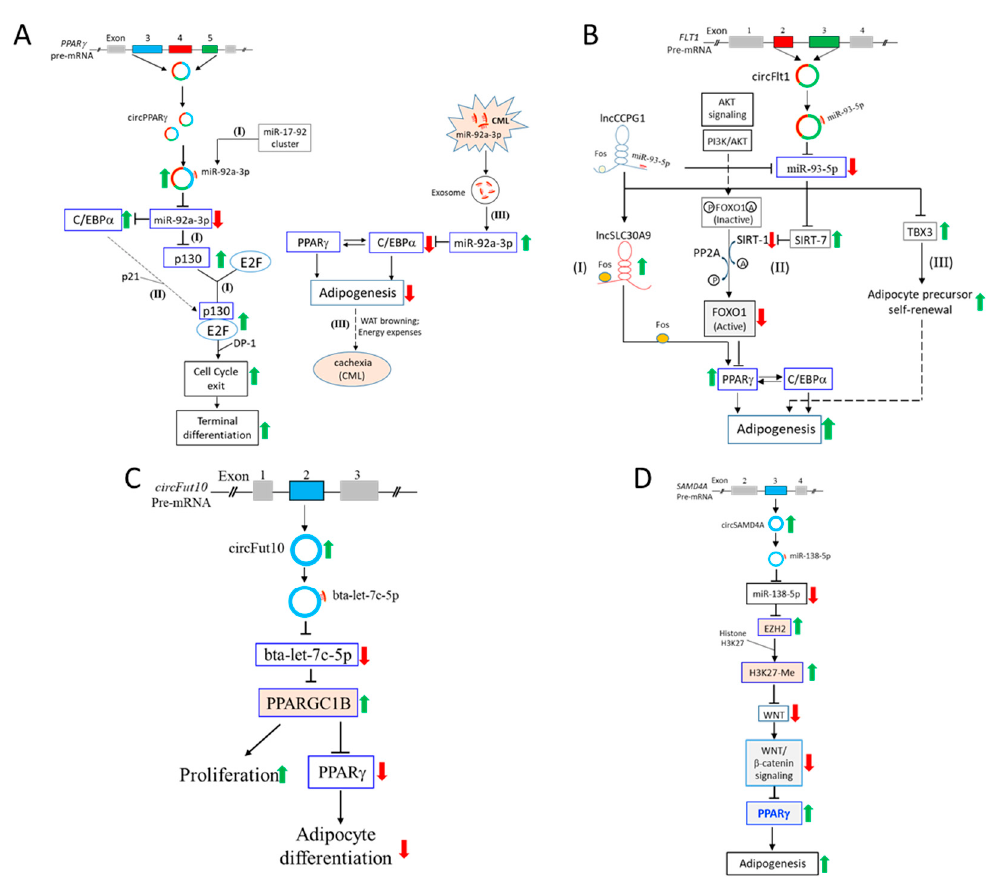
Figure 3. Selected circRNA- and miRNA-mediated post-transcriptional regulation of signaling and biochemical pathways in preadipocyte differentiation. ( A ) CircPPAR γ sponges miR-92a-3p to regulate C/EBP α and p130/Rb2. Depicted are the impacts of circPPAR γ sponging of miR-92a-3p on adipogenesis via p130 (left panel, route I) and C/EBP α (left panel, routes I and II). Cancer-associated cachexia in chronic myeloid leukemia (CML) through adipogenesis is also shown (right panel, route III). ( B ) CircFLT1 sponges miR-93-5p to regulate SIRT-7 and TBX3. Route (I) involves lncCCPG1 and lncSLC30A9 and the c-Fos protein; route (II) depicts SIRT-1 and -7 and the FOXO1 pathway targeting PPAR γ ; route (III) illustrates TBX3 regulation of precursor renewal prior to differentiation in the early stage of adipogenesis. ( C ) The circFUT10-let-7c-5p-PCG1 β regulatory pathway. Negative modulation of preadipocyte differentiation by circFUT10 is shown. ( D ) The circSAMD4A-miR-138-5p-EZH2 pathway. In this pathway, circSAMD4A sponges miR-138-5p to modulate EZH2-induced histone methylation. See text for further description and for sources based on which the schemes are constructed. In all subfigures, thin and blunted arrows indicate positive and negative regulation, respectively, in normal cells; thick upward-pointing green and red downward-pointing arrows indicate the modulatory effects of the circRNAs on the proteins in the pathway accumulating to the modulation of preadipocyte differentiation in adipogenesis; arrowheads with dashed lines indicate other multi-step pathways, the details of which are not indicated.